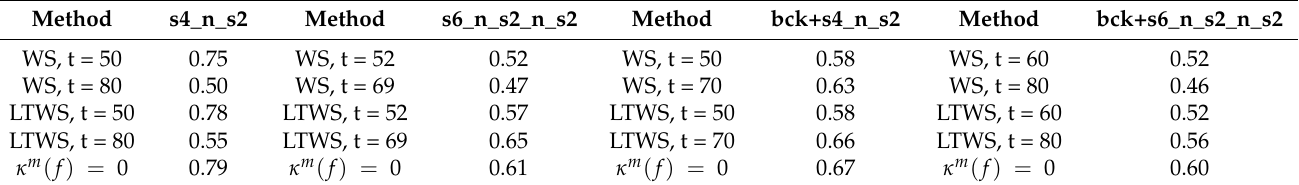
Figure 2. The results of pore segmentation test. Notations: bck—nonlinear background; s4_n_s2 and s6_n_s2_n_s2 denote the sequence of Gaussian blur (s) and Gaussian noise (n) added to the test image, see text for details; t denotes the threshold used for obtaining the marker image. Table 1. Jaccard index J ( ground truth , segmented image ) calculated for the binary images of the segmented pores shown in Figure